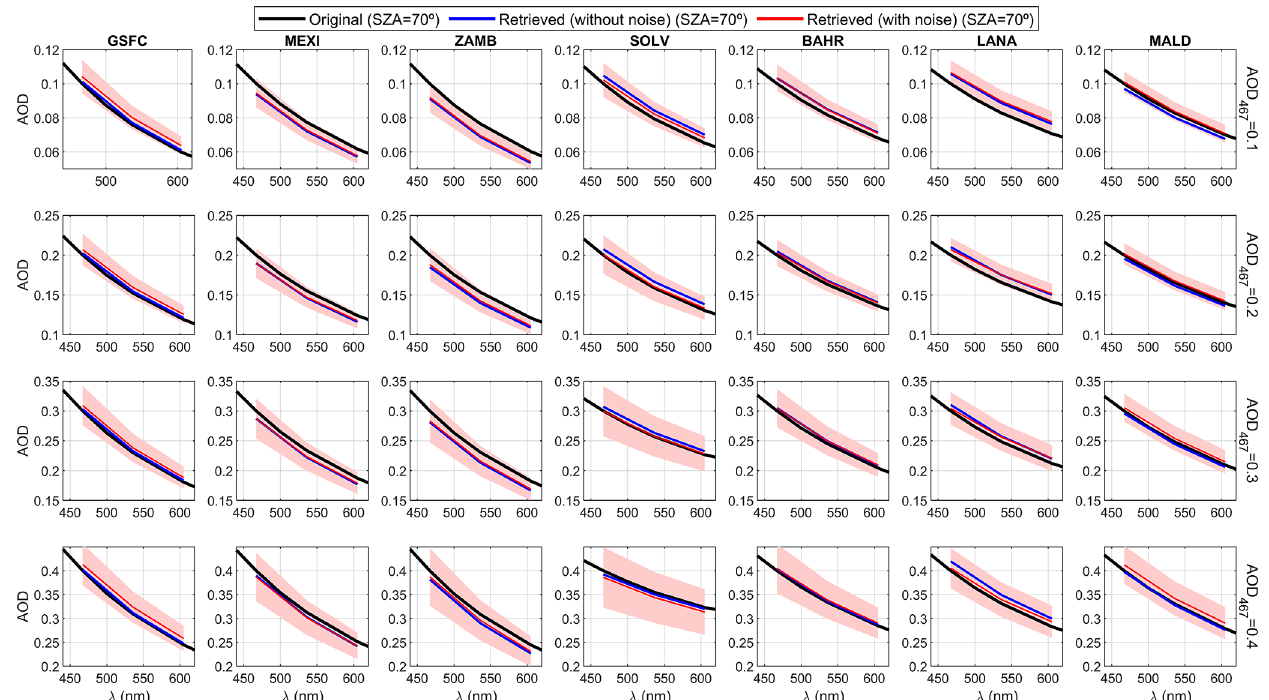
Figure 4. Aerosol optical depths (AODs) used as reference (black line), AODs retrieved without noise (blue line), and the median of all AODs retrieved with noise (red line) for solar zenith angle (SZA) equal to 70 ◦ . These AOD values are represented for different aerosol types (one type per column) and for AOD values at 467nm (AOD 467 ) of 0.1 (first row), 0.2 (second row), 0.3 (third row) and 0.4 (last row). Red shadowed area corresponds to ± the standard deviation of all averaged size distributions retrieved with noise-perturbed